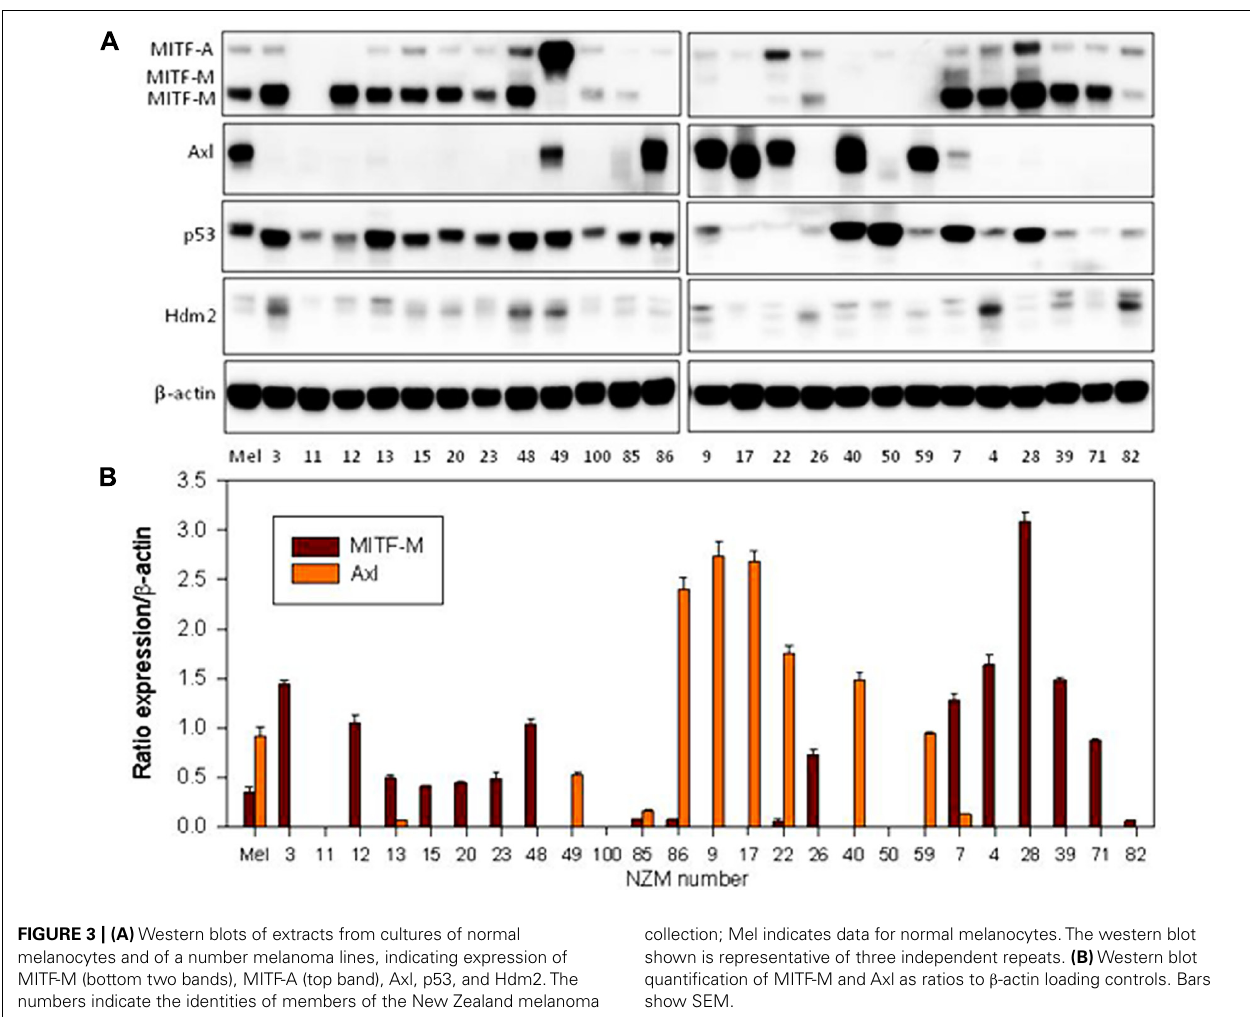
FIGURE 3 | (A) Western blots of extracts from cultures of normal melanocytes and of a number melanoma lines, indicating expression of MITF-M (bottom two bands), MITF-A (top band), Axl, p53, and Hdm2.The numbers indicate the identities of members of the New Zealand melanoma